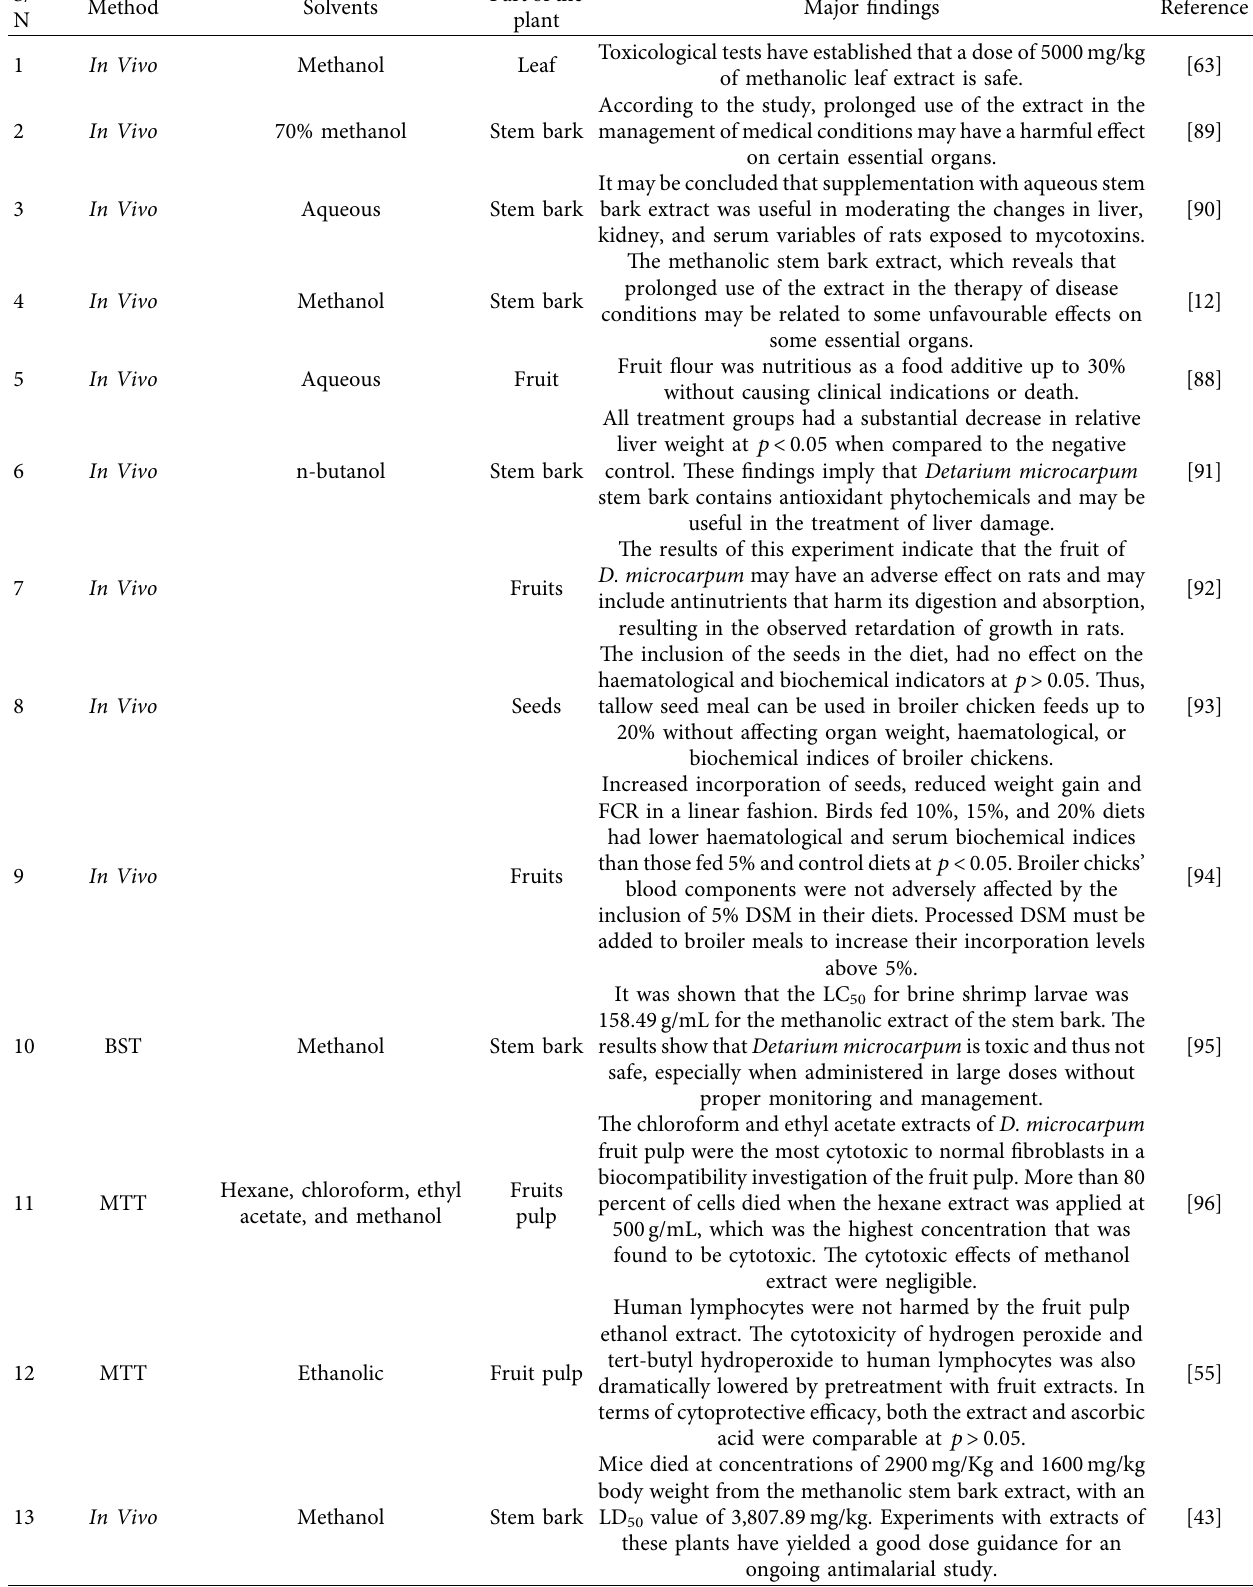
Table 10: Toxicity evaluation of D. microcarpum